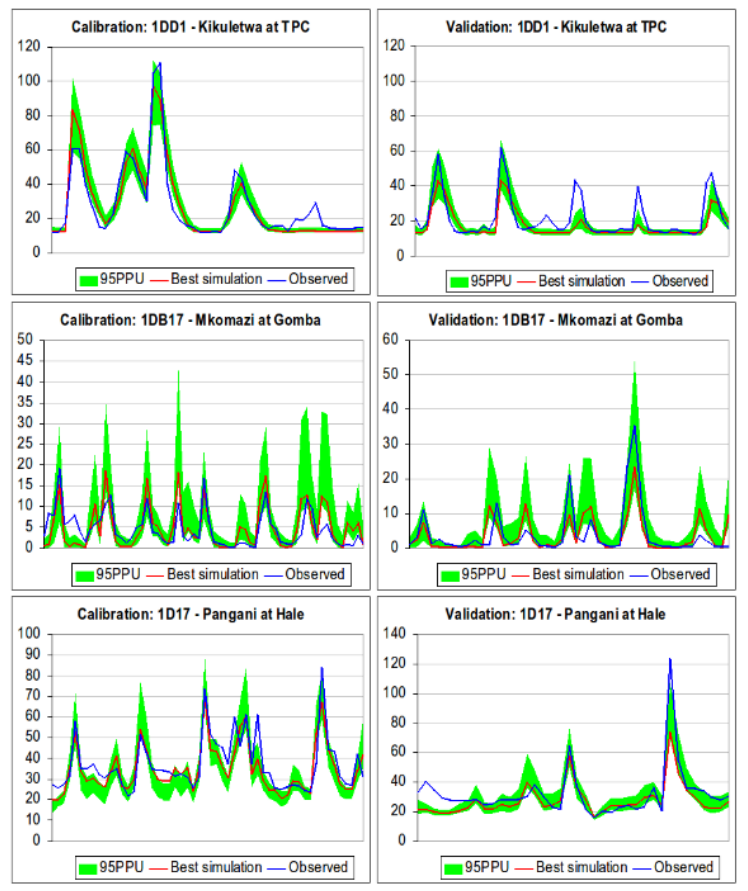
Fig. 5. Hydrographs from three gauging stations in the Pangani Basin comparing modelling results (95PPU, best simulation) to observed discharge (left panels: calibration; right panels: validation).